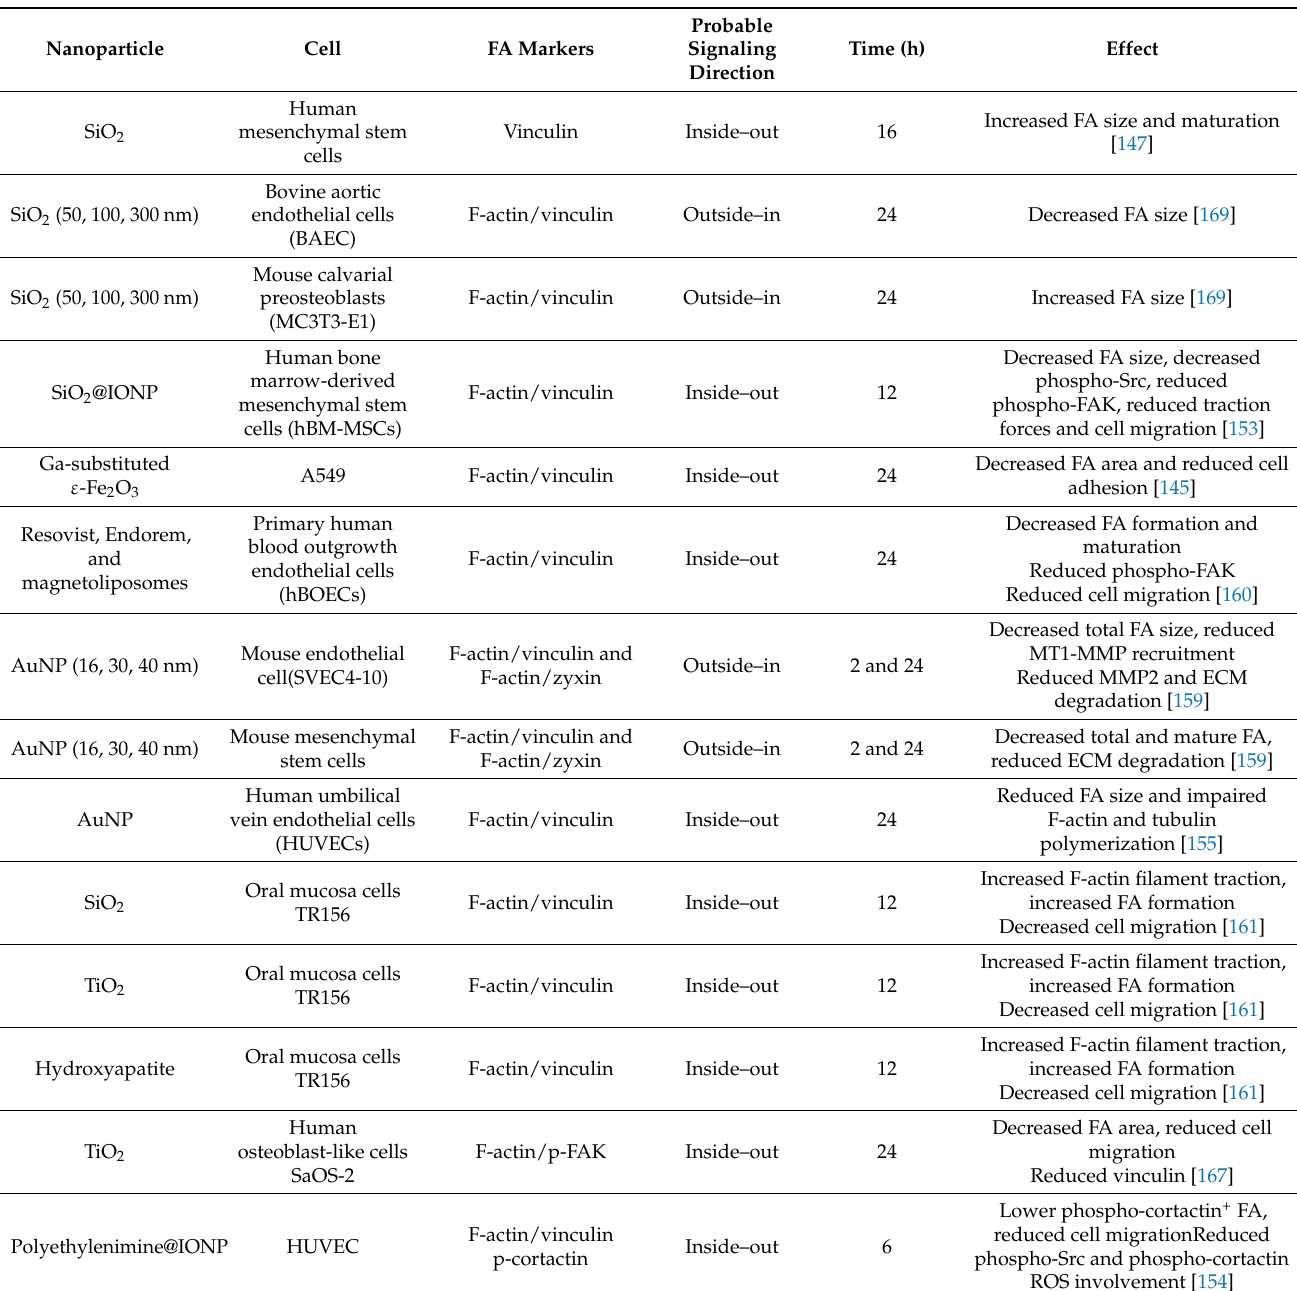
Table 2. List of inorganic nanoparticles and their effect on focal adhesion